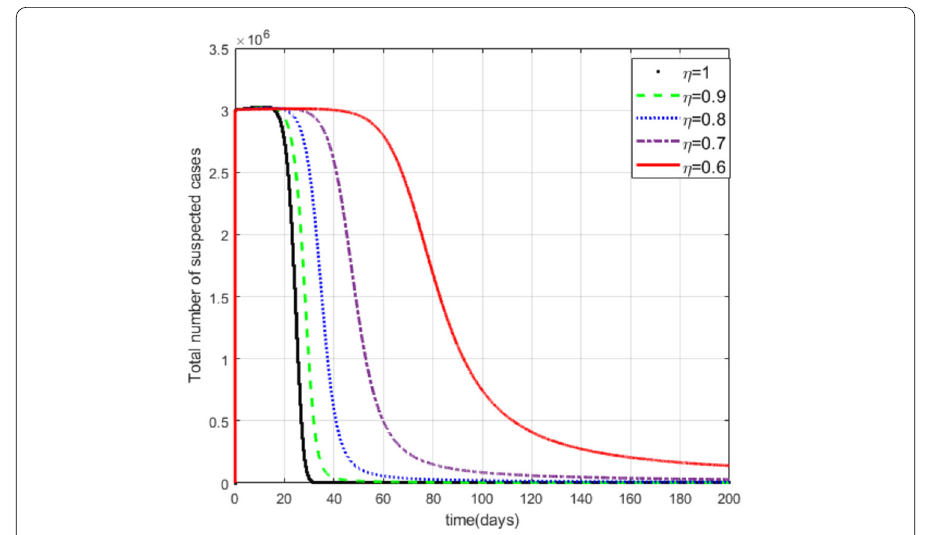
Figure 2 Total number of suspected cases (S) for different values of η